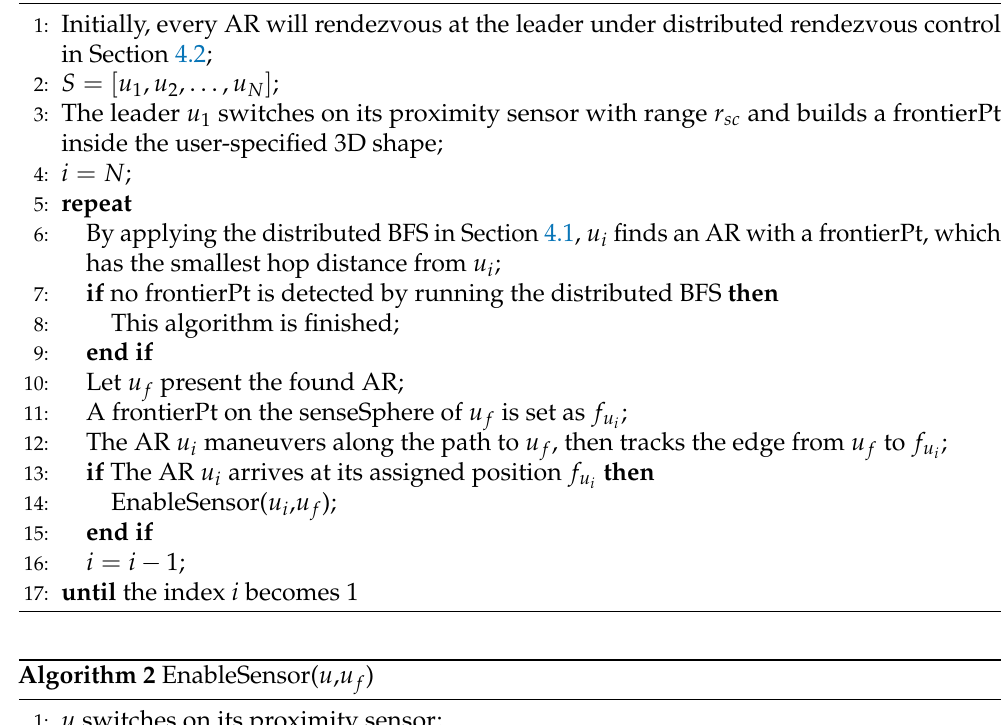
Algorithm 1 Formation